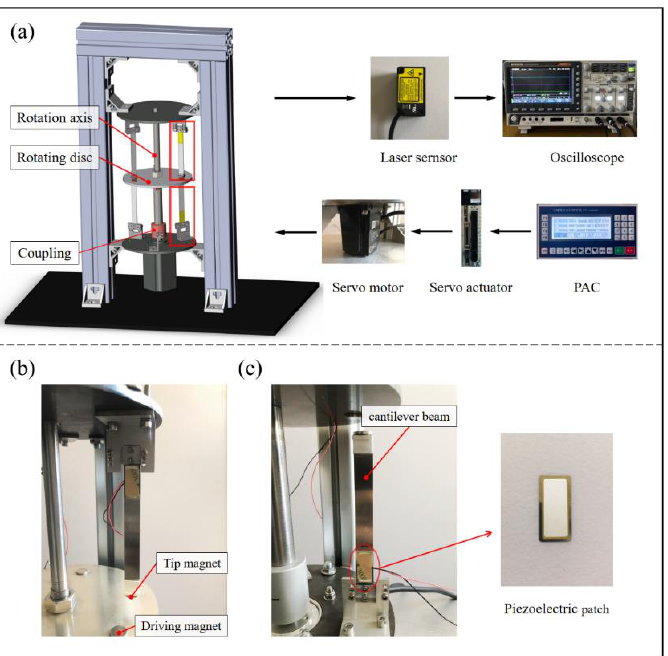
Figure 3. ( a ) Experimental setup of a rotational magnetic couple piezoelectric energy harvester, ( b ) the inverse piezoelectric beam, and ( c ) the forward piezoelectric beam.